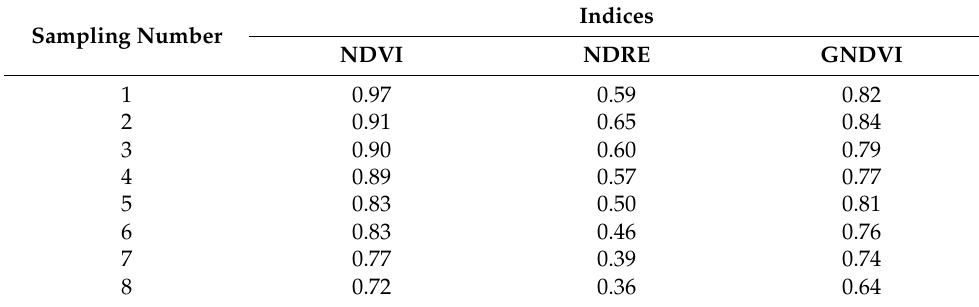
Table 4. The calculated values of the vegetation indices.